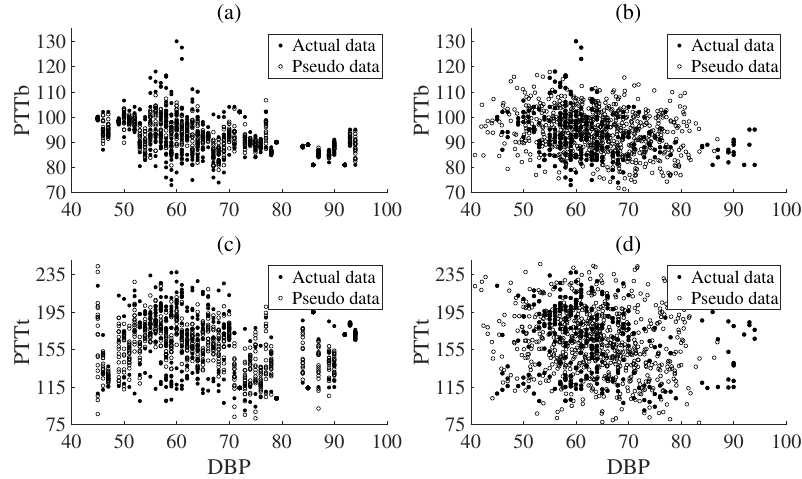
Figure 5. Data augmentation results for PTTb, PTTt and reference DBP (unit: mmHg). ( a , c ): the bootstrap algorithm, ( b , d ): the proposed